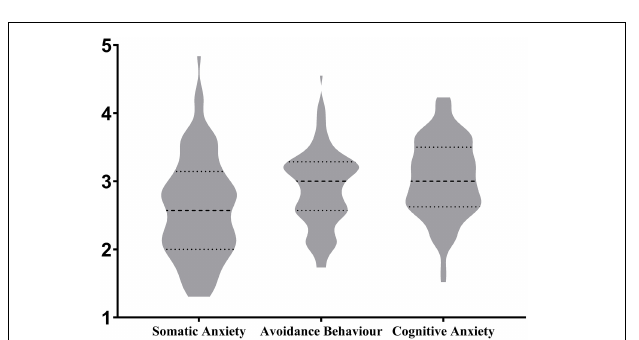
FIGURE 2 | Overview of L2 writing anxiety.